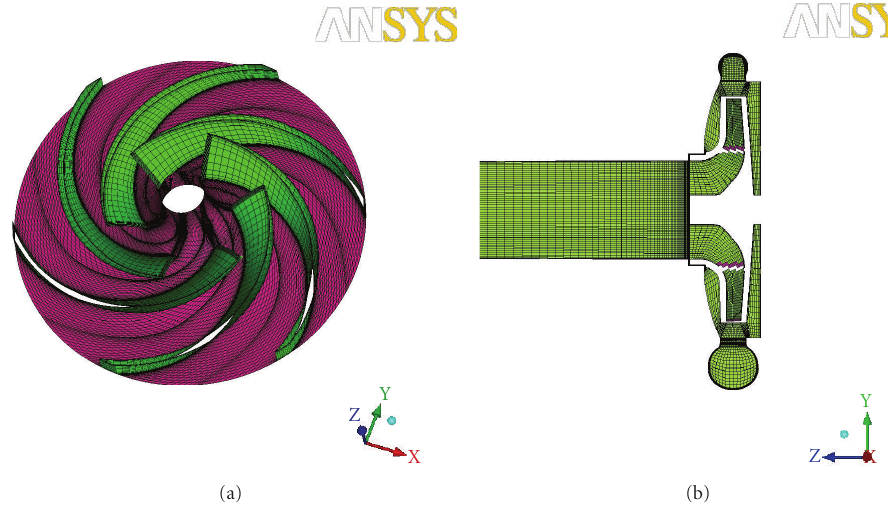
Figure 3: (a) Mesh of impeller. (b) Mesh assembly.